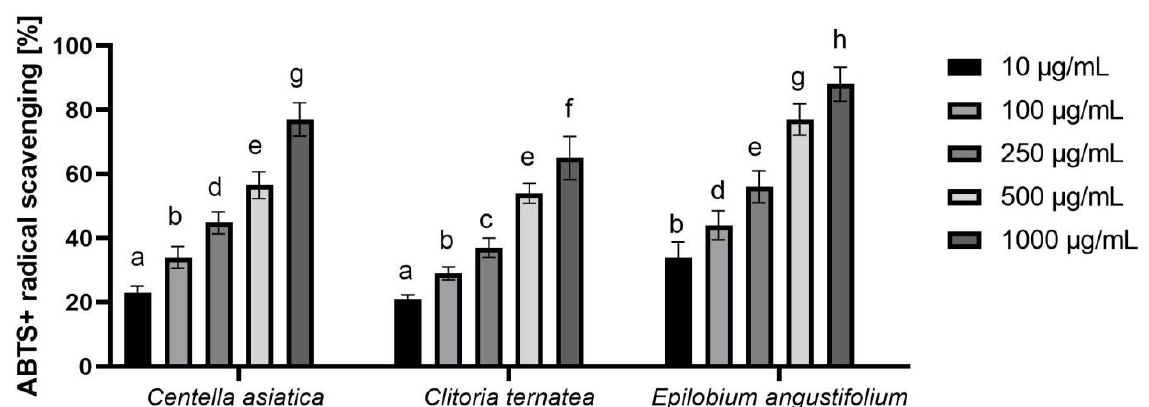
Figure 3. ABTS scavenging by extracts of Centella asiatica L., Clitoria ternatea L. and Epilobium angustifolium L. Values are the mean of three replicate determinations (n = 3). Different letters on the charts indicate significant differences between groups ( p < 0.05).